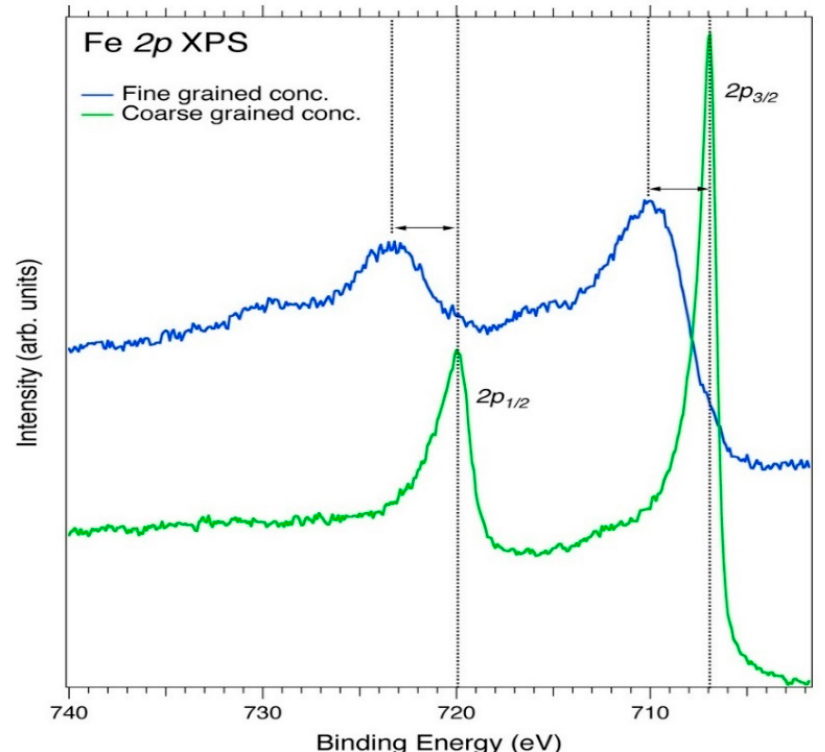
Figure 7. Fe 2p core-level XPS spectra of the fine-grained Au concentrate and coarse-grained Au concentrate samples. The broken line connects the peaks as well as the apparent spin-orbit splitting maxima.